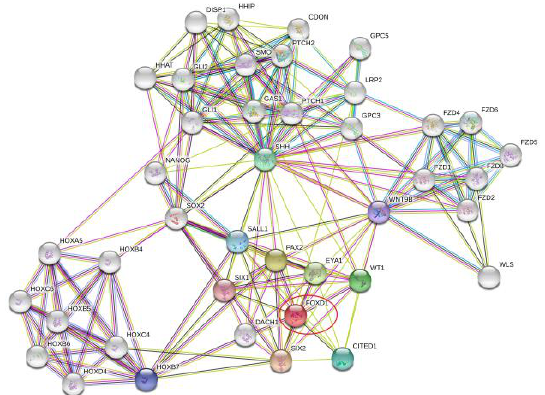
Figure 5. The prediction regarding protein – protein interactions of FOXD1 is shown according to the database available online (https://string-db.org/ (accessed on 21 July 2021)). FOXD1 might be co- expressed with SIX1 and SIX2 of the SIX family, as well as with PAX2, EYA1, WT1, and CITED1. In addition, FOXD1 has a close relationship with